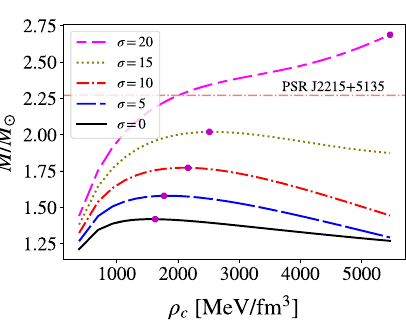
(b) Mass-central density relation for polytropic stars. Fig. 2 Mass-radius ( a ) and mass-central density ( b ) relations for sev- eral values of σ for the polytropic EoS. The magenta circles mark the maximum mass on each curve. In panel ( a ) the Buchdahl and Schwarzschild limits are indicated by an orange-dotted and a gray- dotted line,